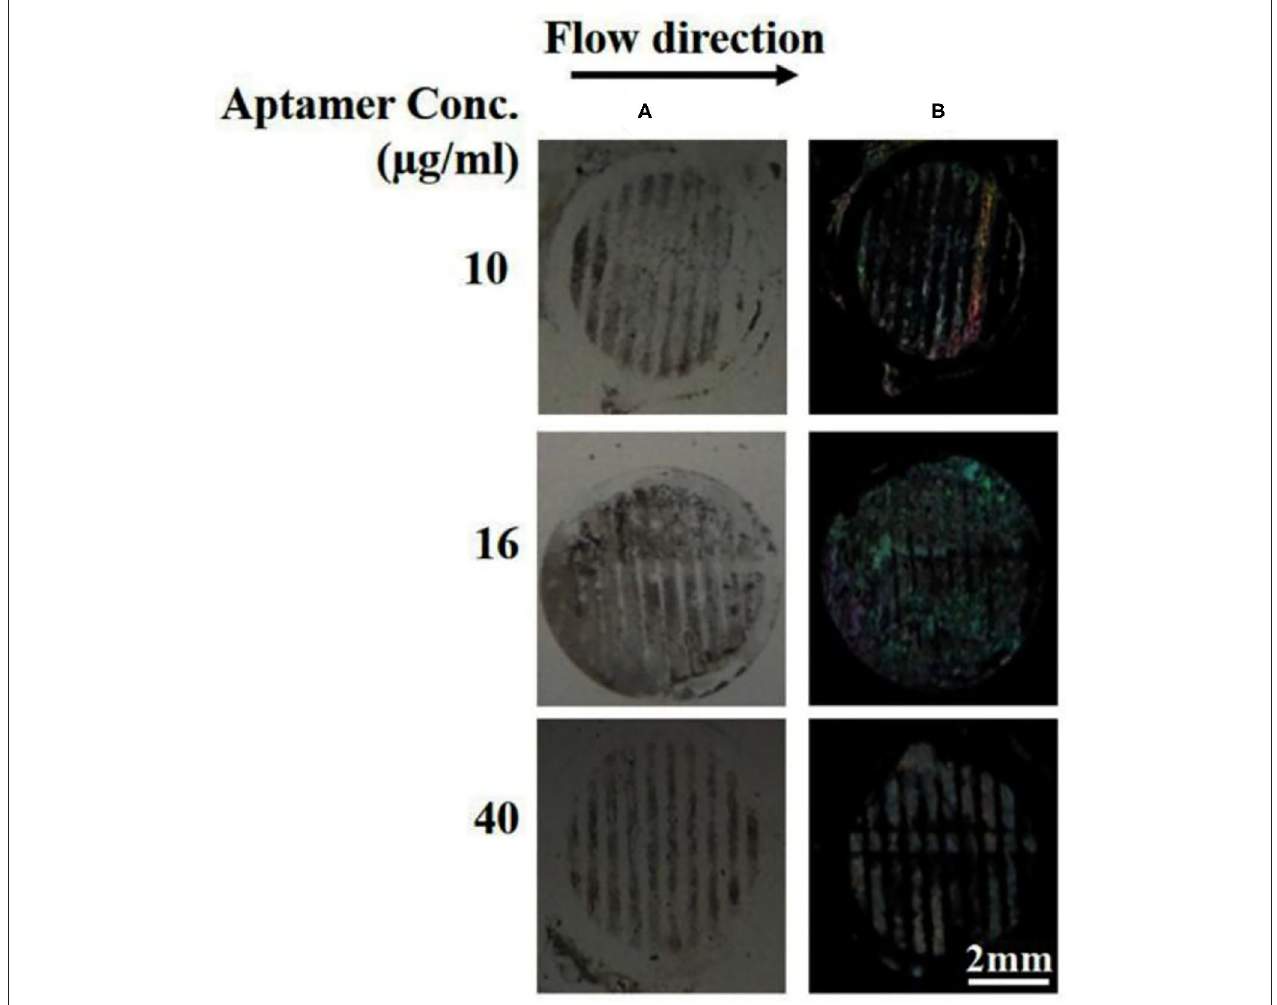
FIGURE 7 | Specificity by using BSA protein as a control experiment. (A) Optical image of BSA patterns after flowing different concentrations of B40t77 (10, 16, and 40 µ g/ml). (B) Optical images of LC after the assay was completed. The flow rate was 0.5 µ